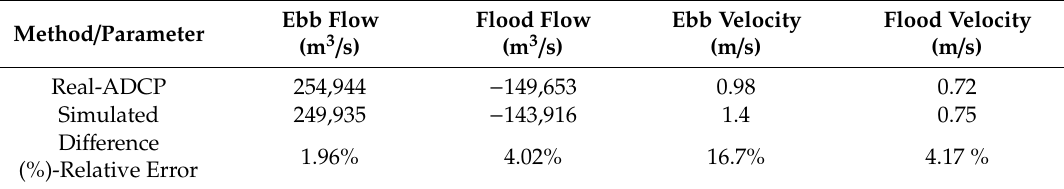
Table 4. Comparative table between CNM data simulated and measured in the field.